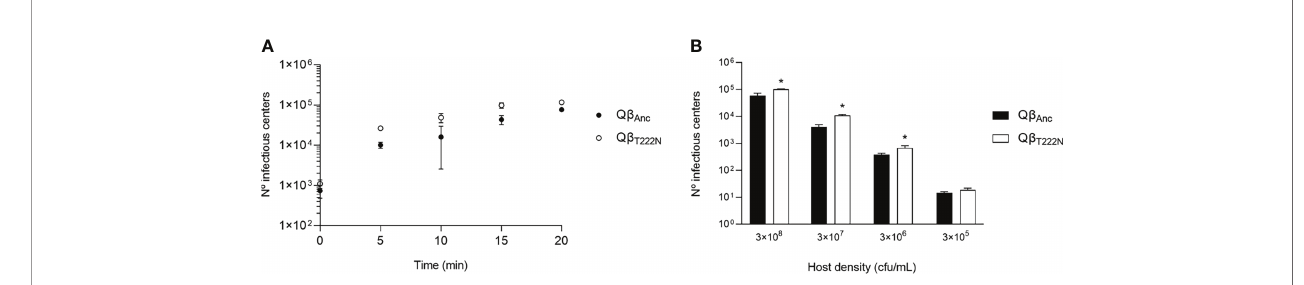
FIGURE 6 | Virus entry into the bacteria. (A) Kinetics of virus entry. 10 5 pfu of either the virus Q b Anc (black circles) or Q b T222N (white circles) were incubated with ~ 3 x 10 8 cfu in a volume of 1 mL. After the times indicated, the samples were processed (see Materials and Methods) to determine the number of infectious centers. Each determination was carried out in triplicate (B) Number of infectious centers produced upon a 10 min incubation. 10 5 pfu of either the virus Q b Anc (black bars) or Q b T222N (white bars) were incubated with different concentrations of bacteria (indicated at the bottom of the fi gure). Each bar represents the average of three determinations. Asterisks above the bars indicate that the result is signi fi cantly different from the value obtained for the virus Q b Anc ( p < 0.05) according to a Mann Whitney test. The absence of asterisk indicates that the value obtained did not signi fi cantly differ from that of